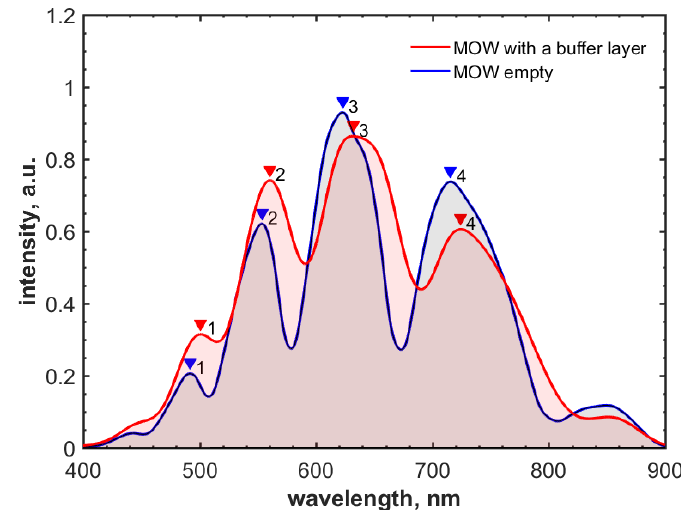
Figure 4. Spectral shifts of local transmission bands induced by poly(styrenesulfonate)/poly(diallyldimethylammonium chloride) (PSS/PDDA) polyelectrolyte layers. Transmission spectra for the empty (uncoated) MOW (blue) and the MOWs coated with the bu ff er layer (red).